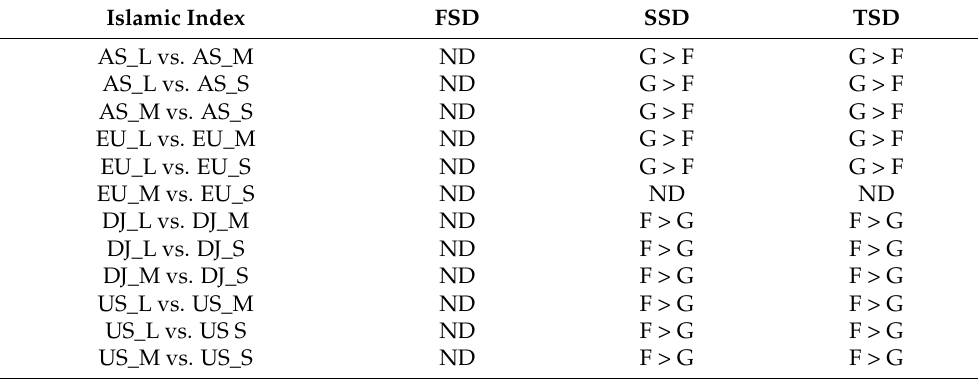
Table 3. Ascending Stochastic dominance (ASD) results of Davidson and Duclos test: sub-period 1 (1996–2006).